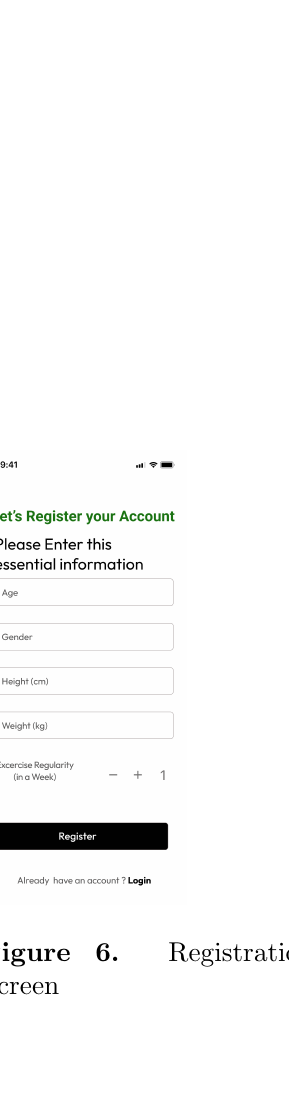
Figure 3. Splash Screen Figure 4. Sign In Screen